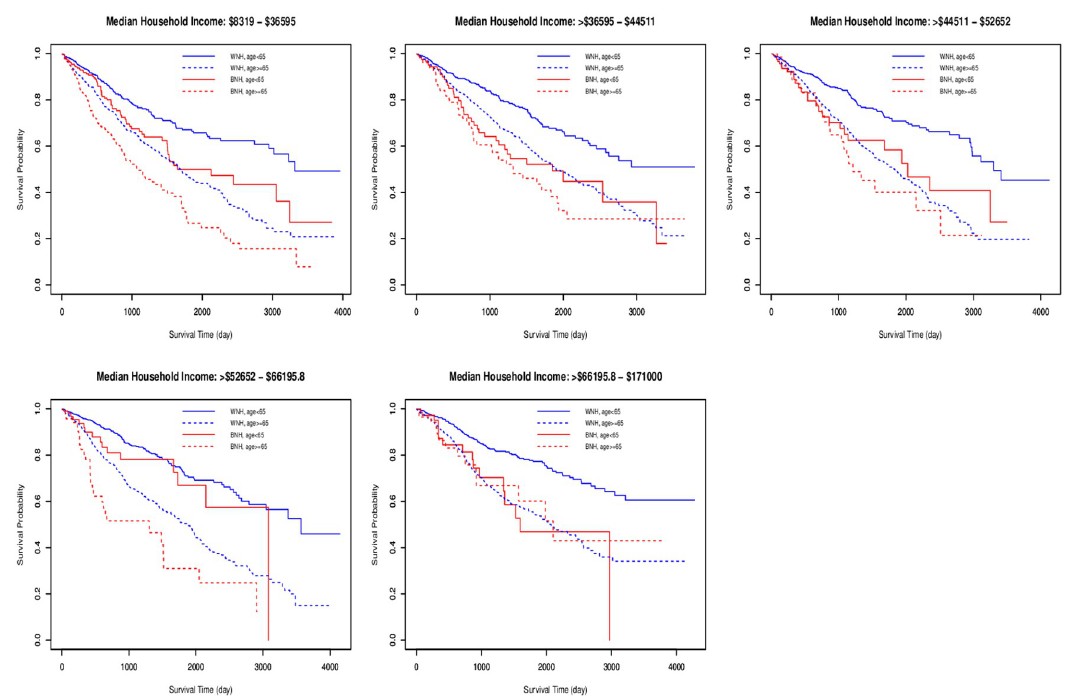
Fig 1. Racial differences in survival broken out by age and MedIncome. Plotted are Kaplan-Meier curves for WNH (blue) and BNH (red).